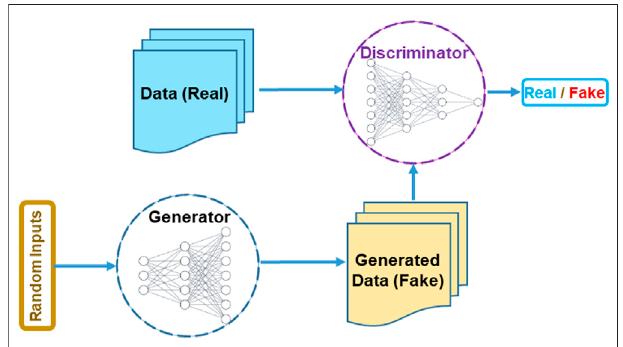
FIGURE 5 | Architecture of a typical GAN model.